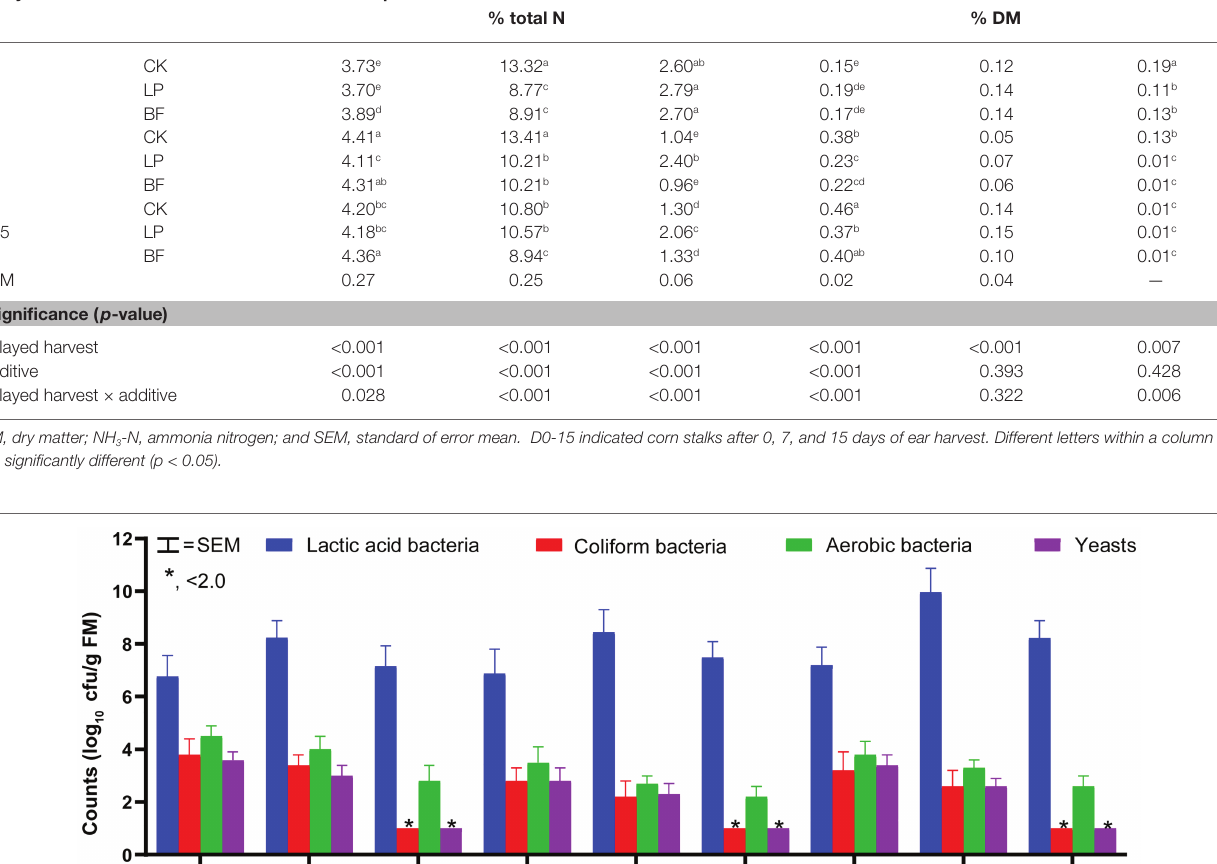
TABLE 3 | Final pH, NH 3 -N, and fermentation acids of corn stalk silages treated without (CK) or with LP and BF. NH 3 -N Lactic acid Acetic acid Propionic acid Butyric acid Delayed harvest Additive Final pH